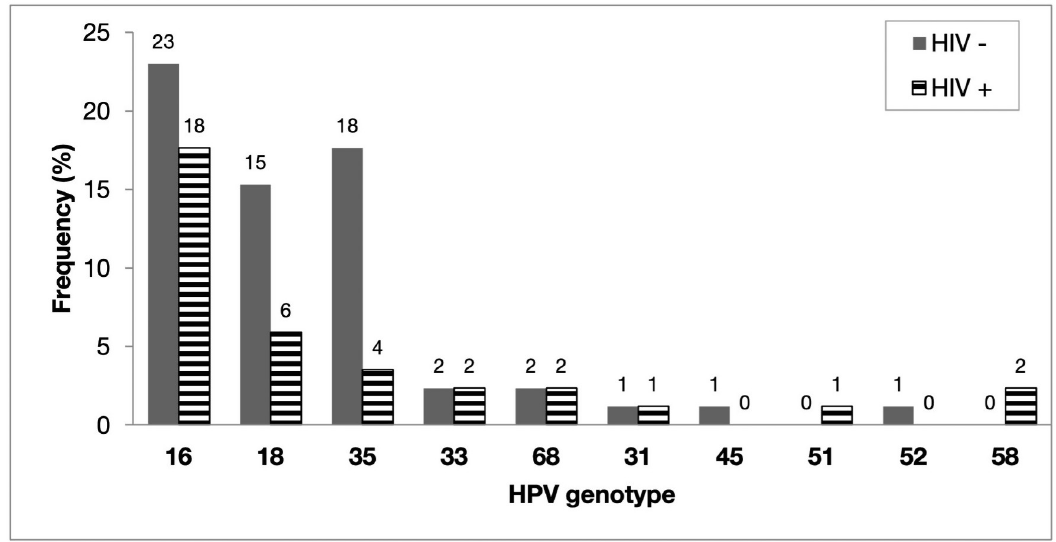
Fig 2. The HPV mono infection distribution in women with confirmed cervical cancer (n = 85). https://doi.org/10.1371/journal.pone.0257324.g002 tumour histology. In this sensitivity analyses, all the co-segregation patterns remained statisti- cally significant except HPV16/33 (OR = 0.4; 95% CI = 0.2–1.9; p = 0.05), HPV35/52 (OR = 0.5; 95% CI = 0.1–4.3; p = 0.50) (S3 Table).